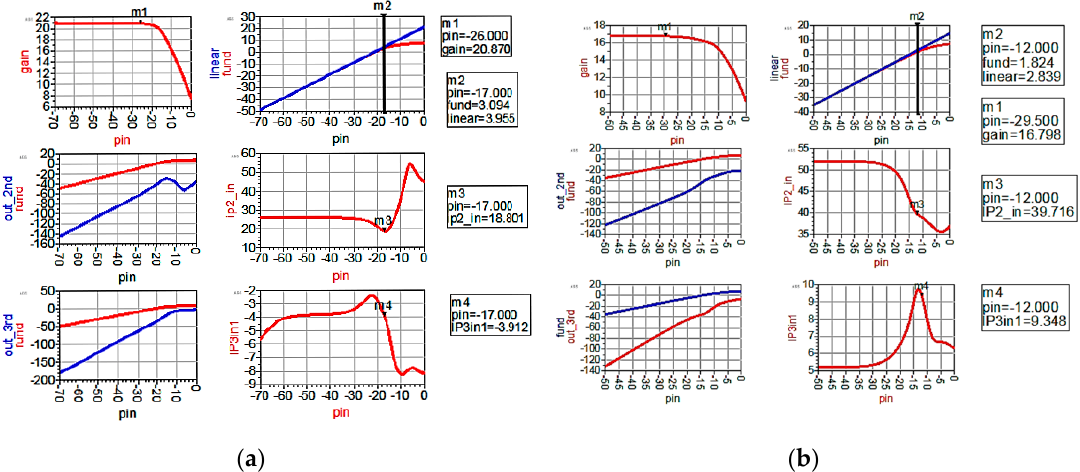
Figure 5. Simulation of IIP3 (third-order intermodulation intercept point) and IIP2 (second-order intermodulation intercept point) in: ( a ) the cascoded inductively degenerated common source (IDCS); and ( b ) the proposed IDCS LNA.